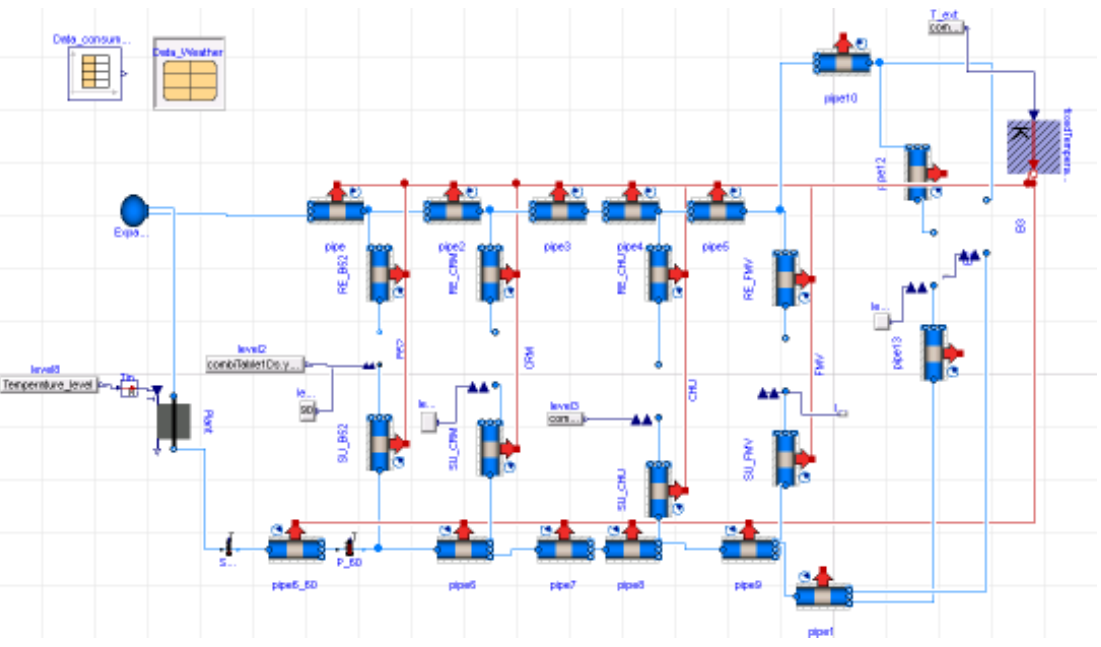
Figure 5. Schematic diagram of one network of the University of Liège DHN under Dymola